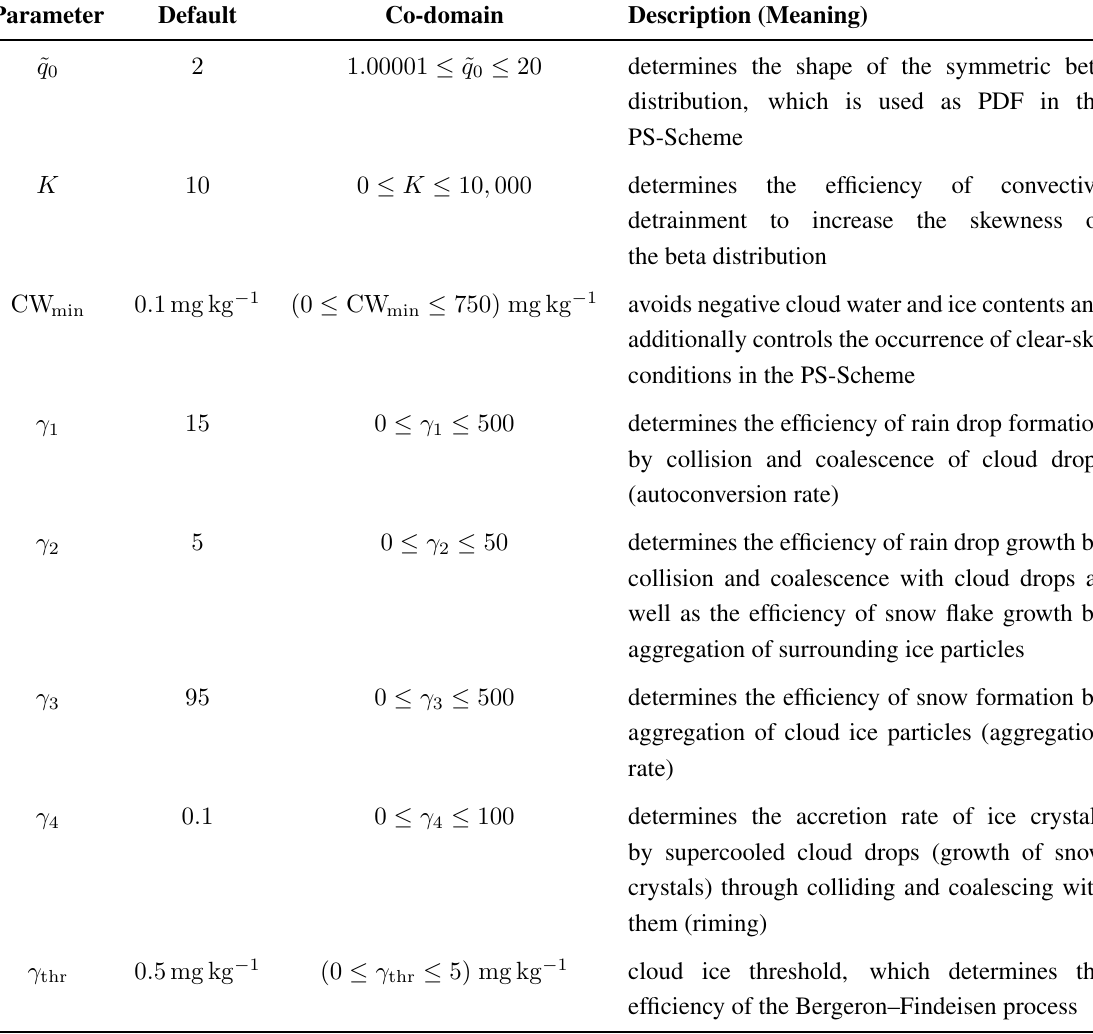
Table 1. Notation, default value, regarded parameter range (co-domain), and description of modified model tuning